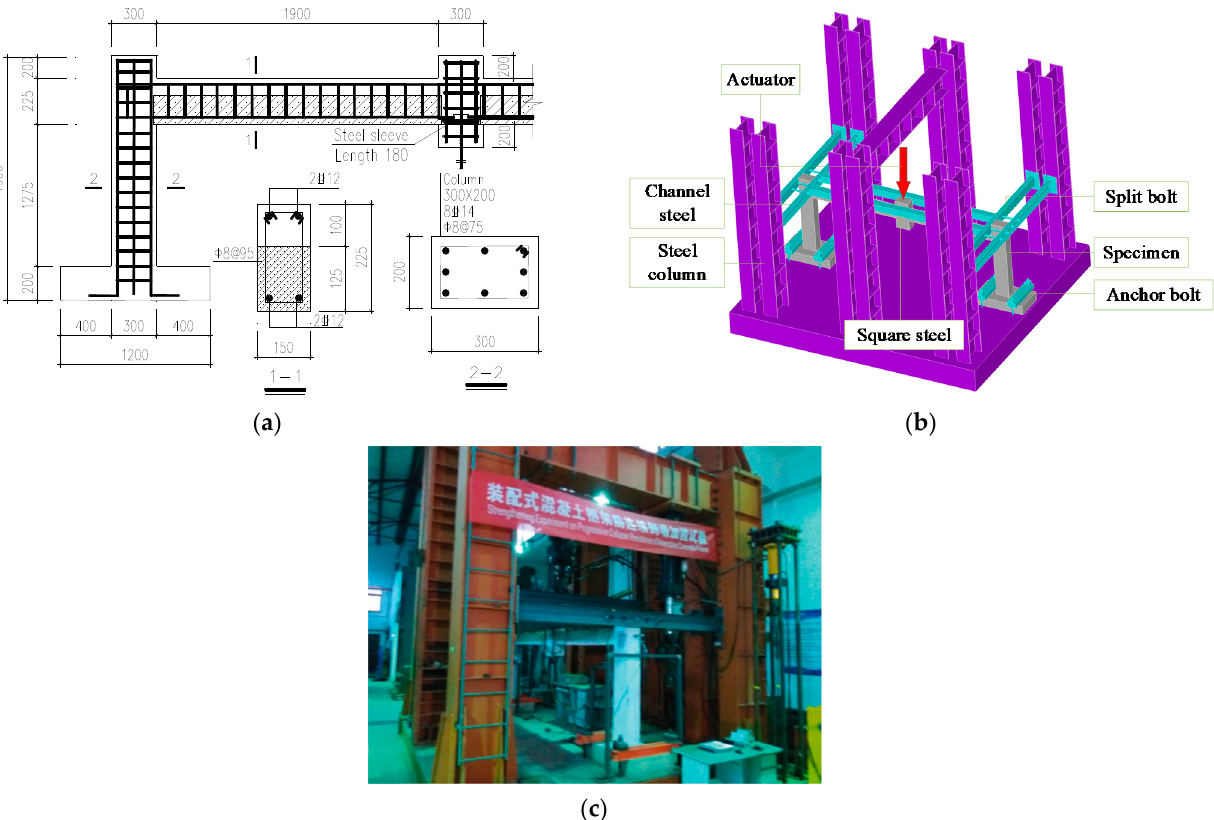
Figure 1. Details and lateral constraint of the subassemblage [19]: ( a ) Details of the subassemblage; ( b ) Lateral constraint arrangement; ( c ) Side view of lateral constraint.